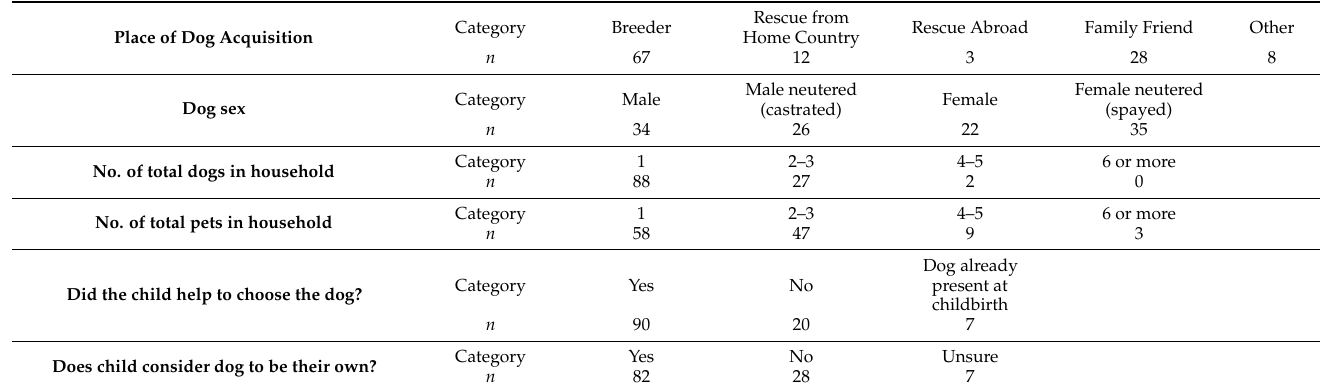
Table 2. Pet dog characteristics ( n